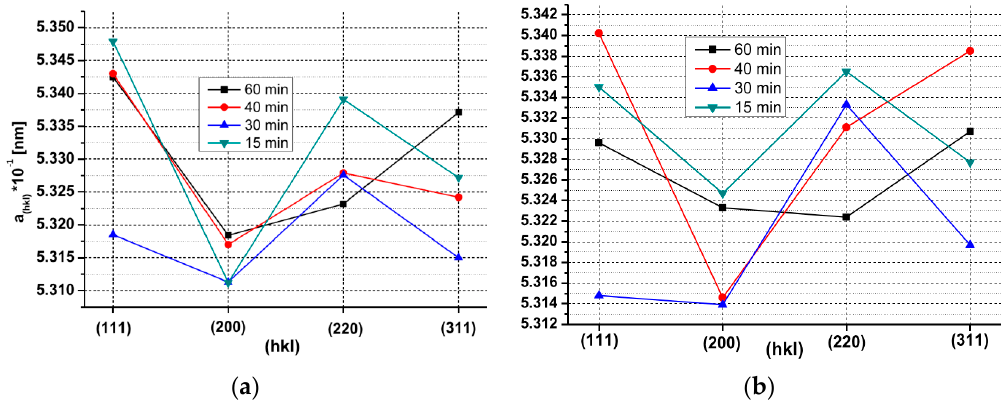
The data for the directions X and Y are presented in Figure 3 in a generalized graphical form.